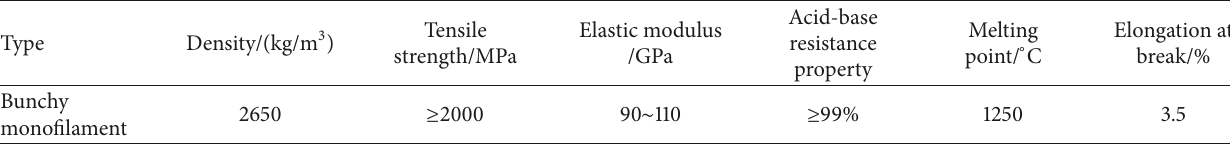
Table 3: The performance parameters of basalt fibre.